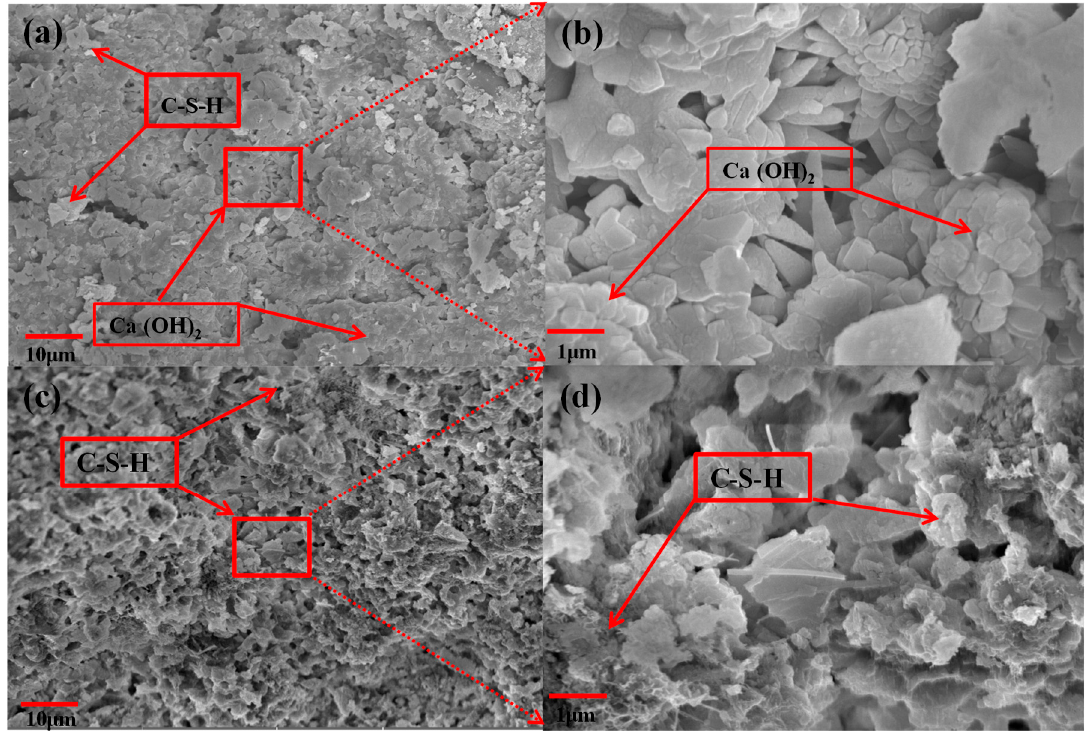
Figure 8. SEM images of ( a , b ) samples N3-0, ( c , d ) samples N3-3.